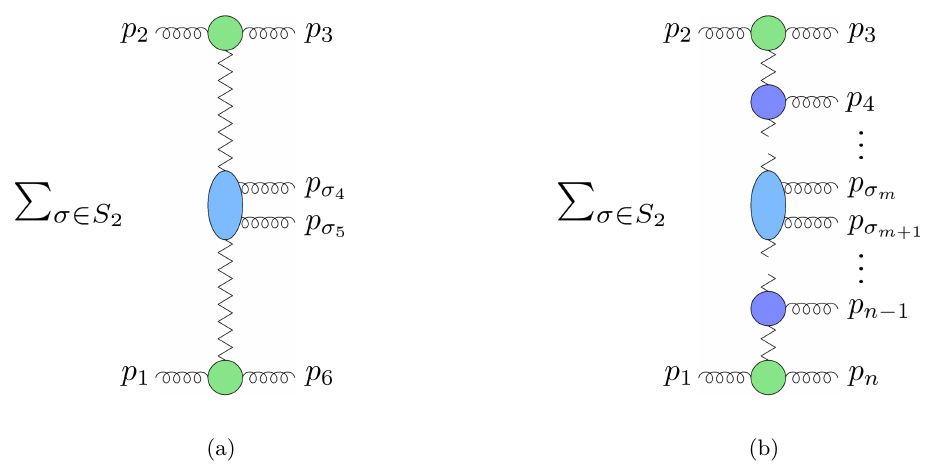
Figure 10 . (a) The expected factorised picture of the dispersive part of a six-gluon amplitude in the central NMRK limit. (b) The expected factorization of an n -gluon amplitude in a central NMRK limit. The coloured blobs represent impact factors, and one- and two gluon CEVs, defined to all orders in perturbation theory, similarly to figure